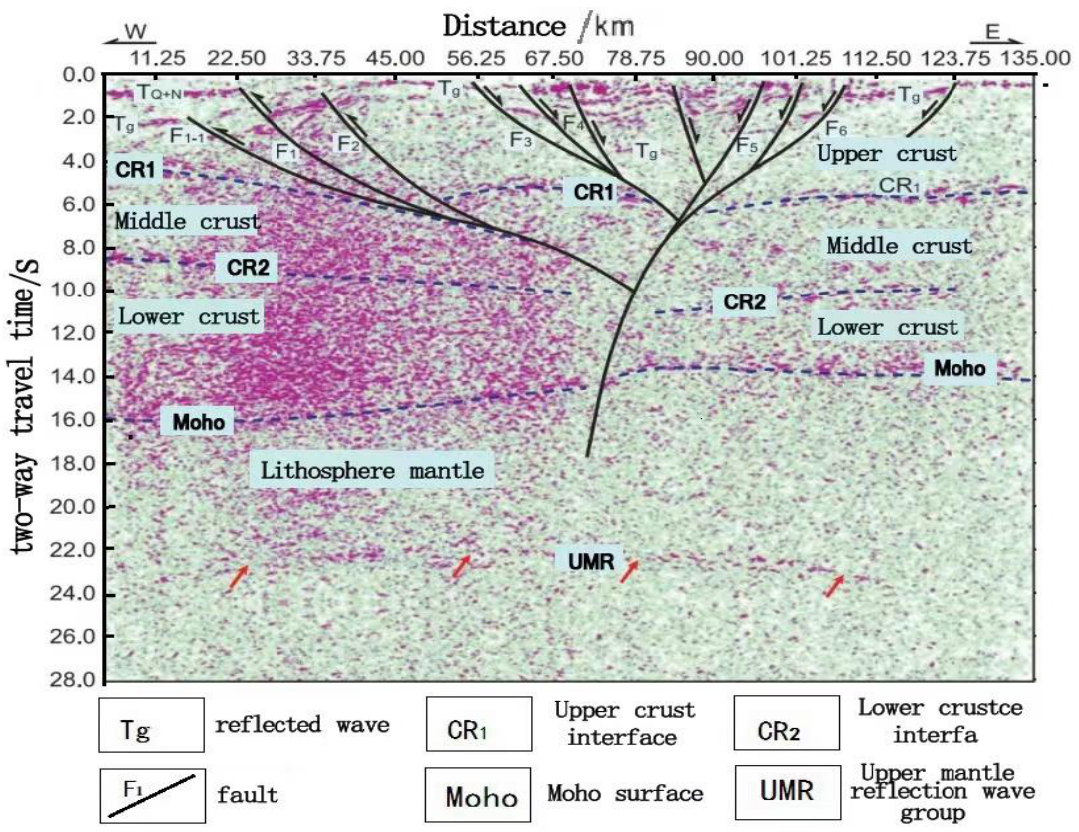
Figure 2. Petroleum seismic profile used to interpretate the Moho surface (Adapted with permission from Ref. [28]. 2017, Springer Nature).